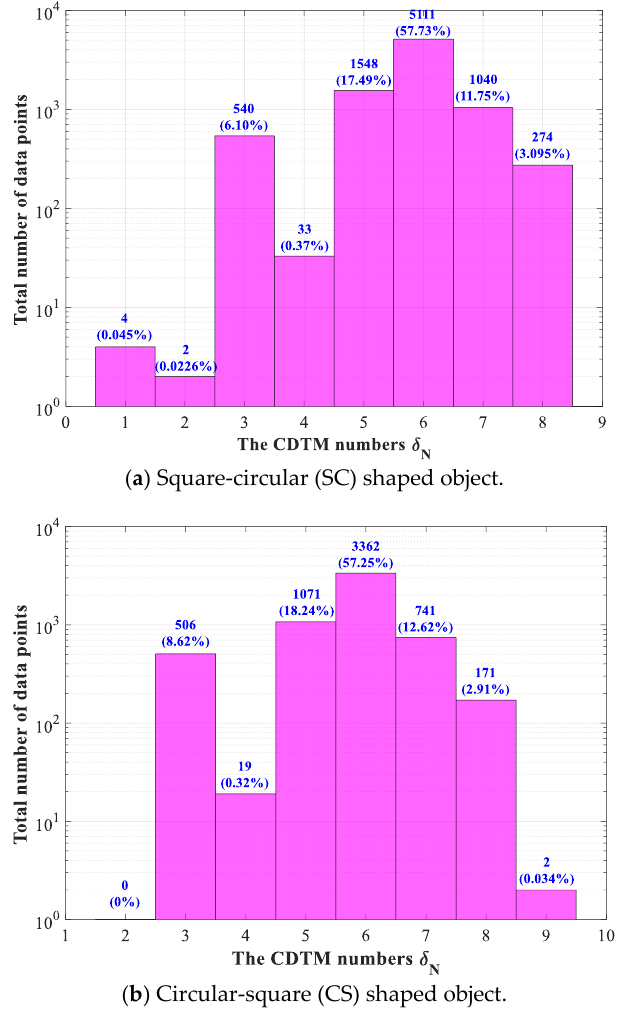
Figure 7. Statistical analyses on the total numbers of data points with different number of CDTMs.